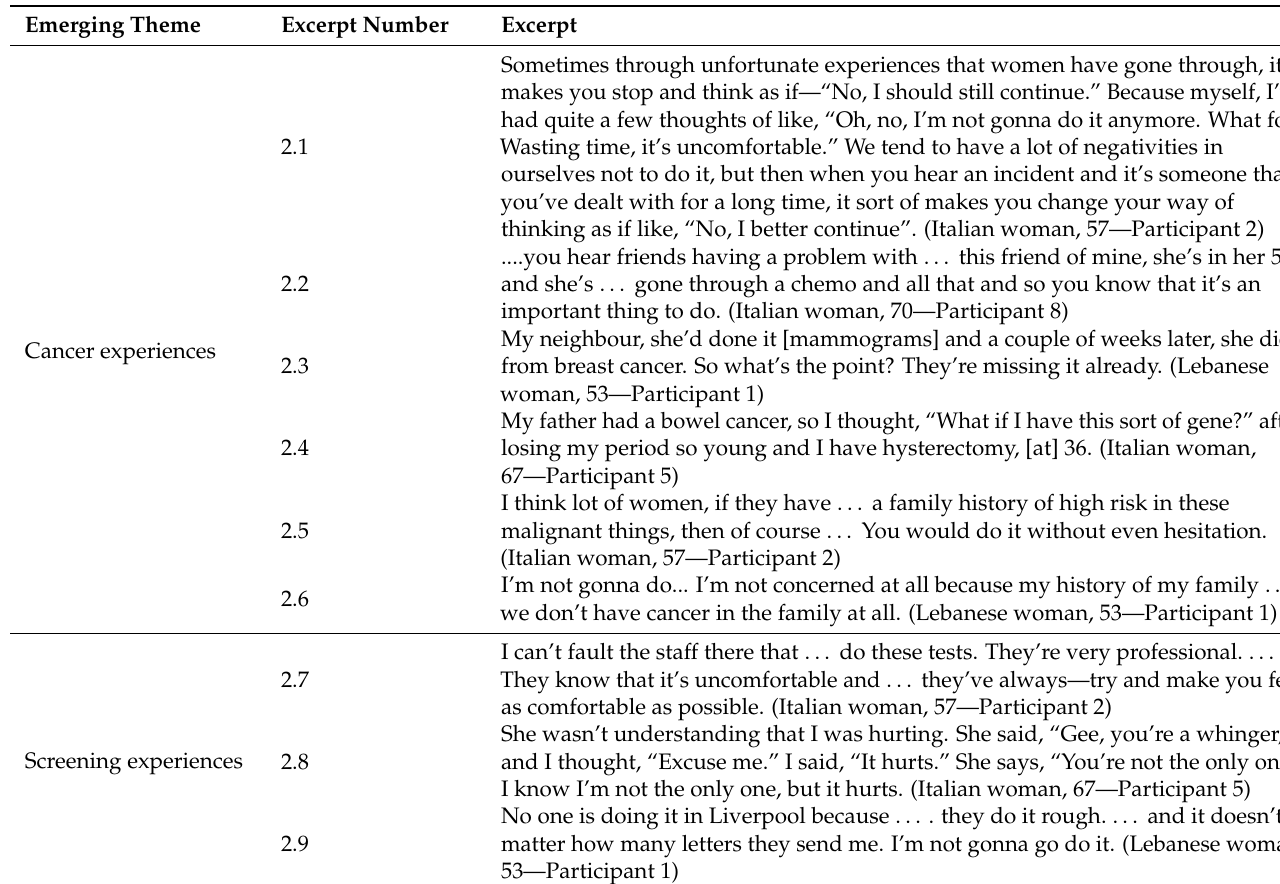
Table 2. Participant-reported healthcare and illness-related experiences.